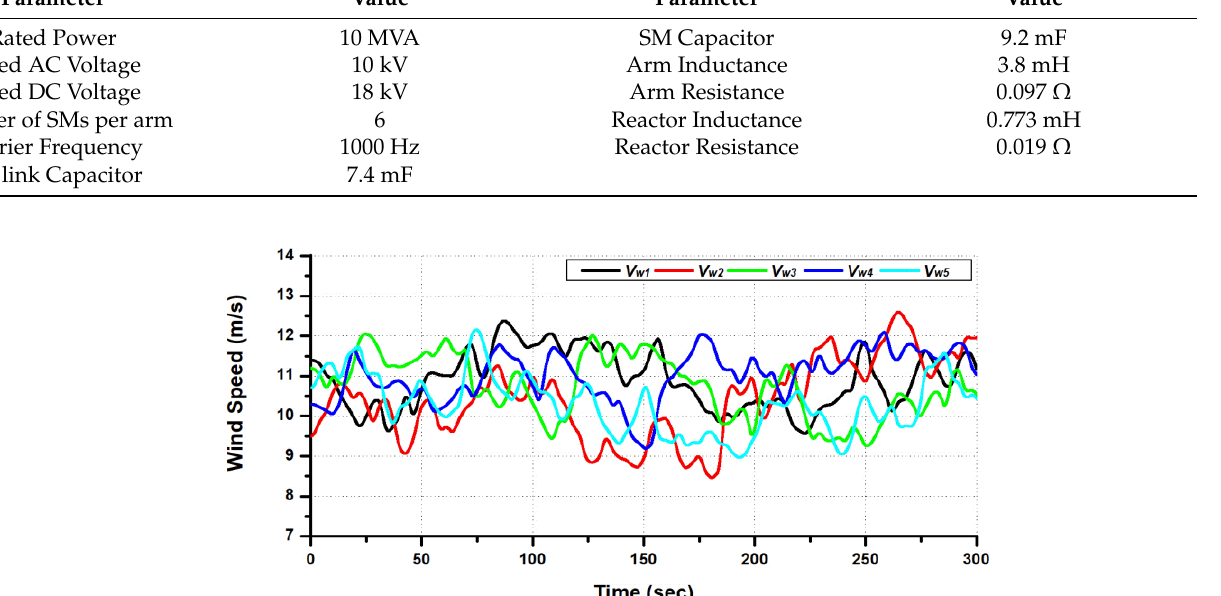
Figure 18. Wind velocity data.